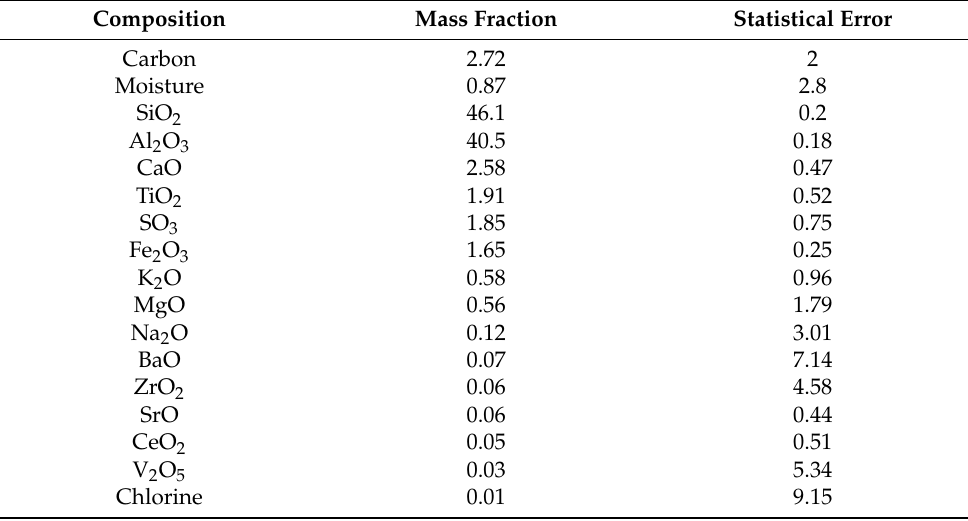
Table 1. Mean composition of fly